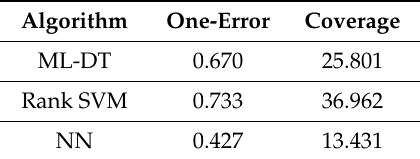
Table 3. Multilabel algorithms’ result.